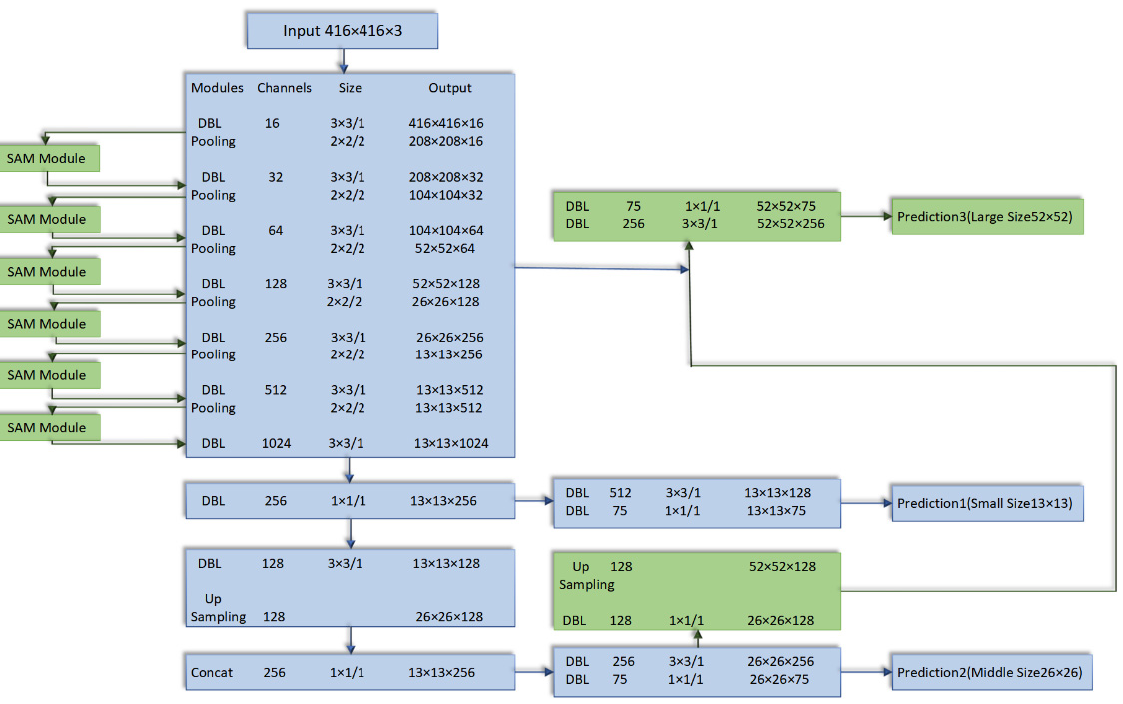
Figure 1. YOLOv3-Tiny_ReSAM network structure (the green box is the improvement